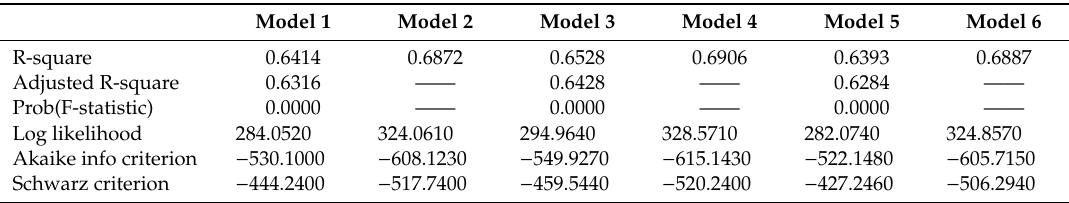
Table 4. Results of parameter estimation of Models